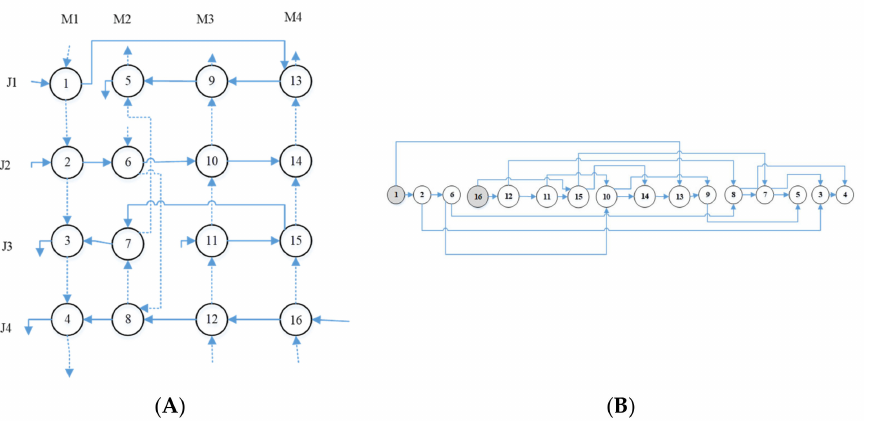
Figure 13. ( A ) Job shop DAG representation; ( B ) the topological sort of the DAG (Madraki & Judd, 2021).